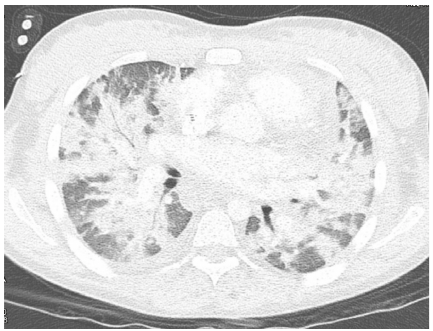
Figure 3: CTA of the chest with IV contrast reveals extensive bilateral consolidations.